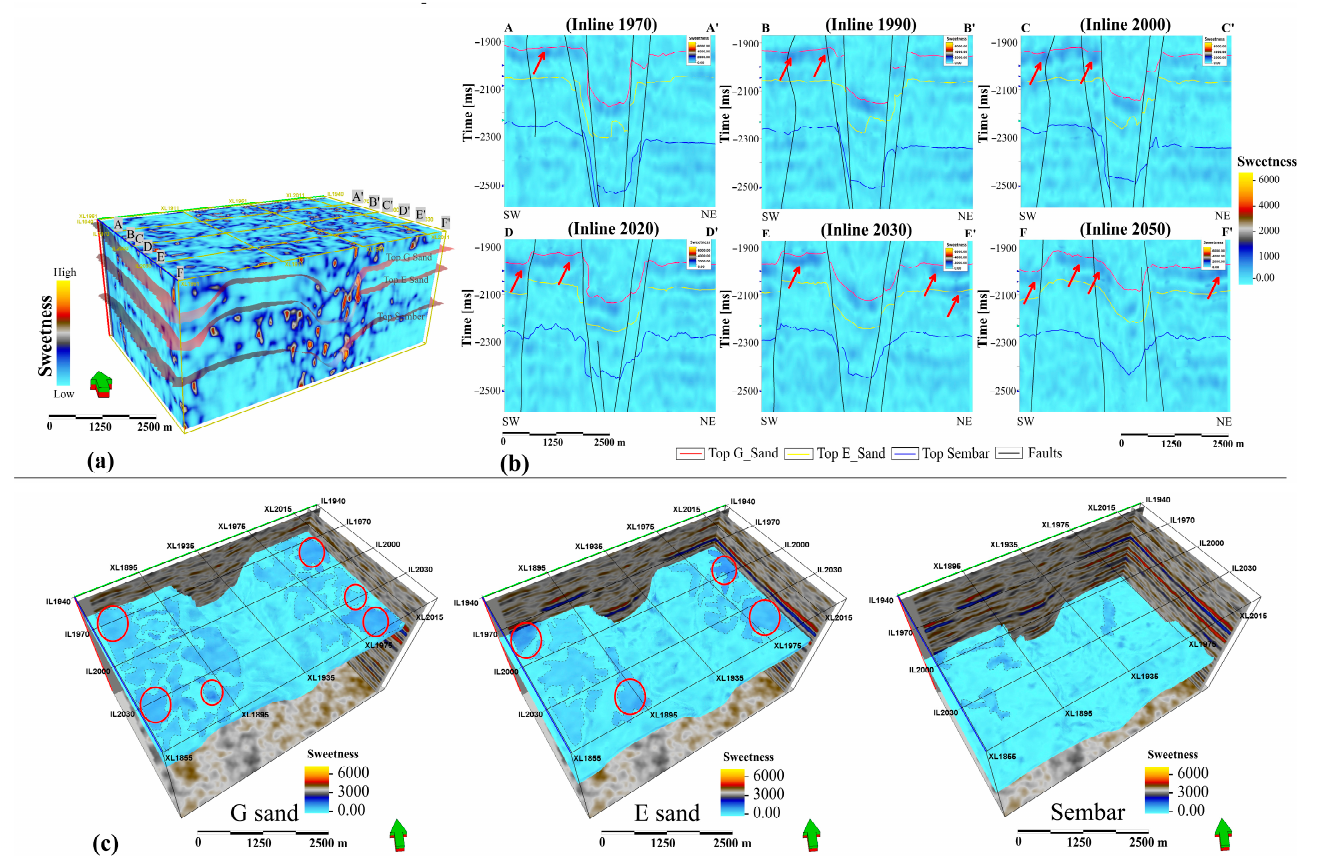
Figure 13. ( a ) 3D sweetness attribute volume, ( b ) 2D extracted sweetness cross-sections, and ( c ) 3D sweetness horizon slices of the G sand interval, the E sand interval, and the Sembar Formation.